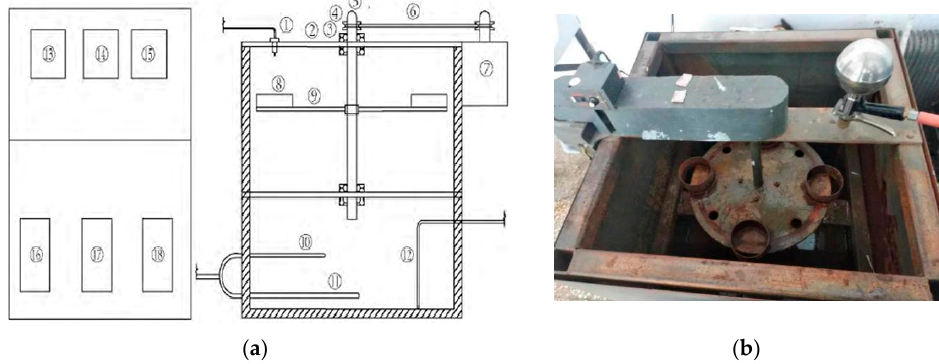
Figure 2. ( a ) The structure diagram of the dynamic water scour instrument. ( b ) The dynamic water scour instrument.